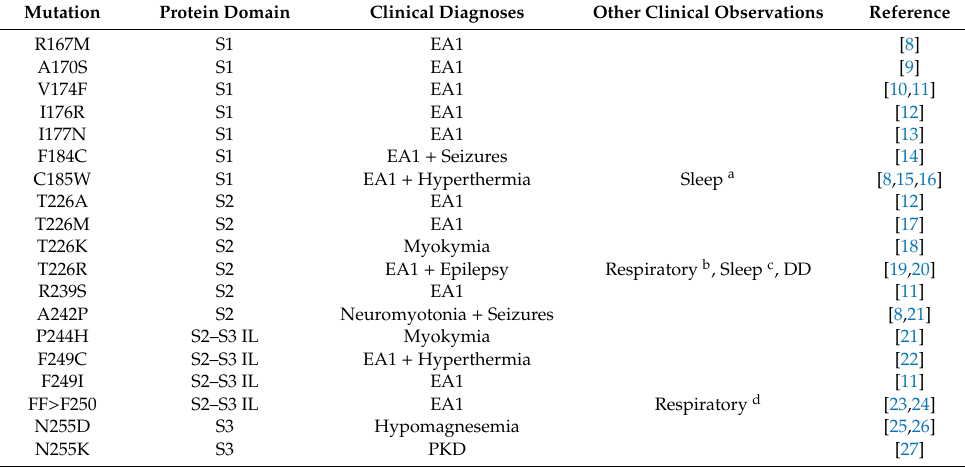
Table 1. Human KCNA1 mutations designated as “pathogenic” or “likely pathogenic” with heterogenous